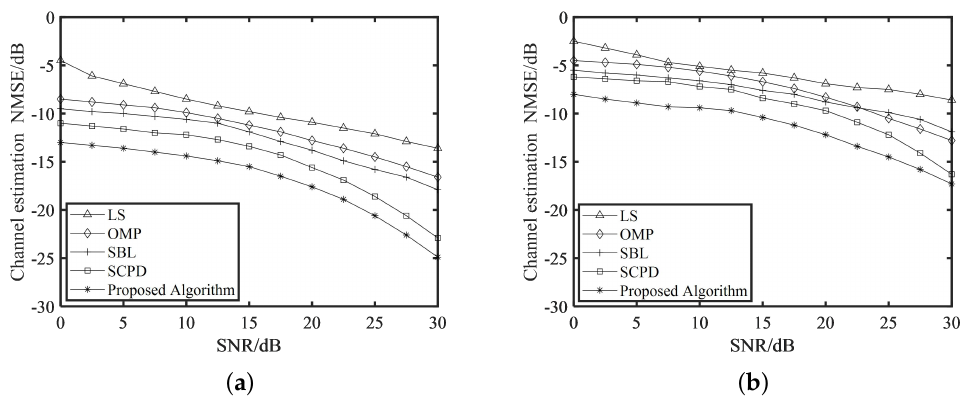
Figure 5. NMSE performance versus SNR for channel estimation. Simulation setup: single vehicle; the number of transmit antennas N R = 16, and the transmit RF chains M R = 16; the number of receive antennas N V = 4, and the receive RF chains M V = 4. ( a ) The vehicle speed is 90 km/h. ( b ) The vehicle speed is 150 km/h.